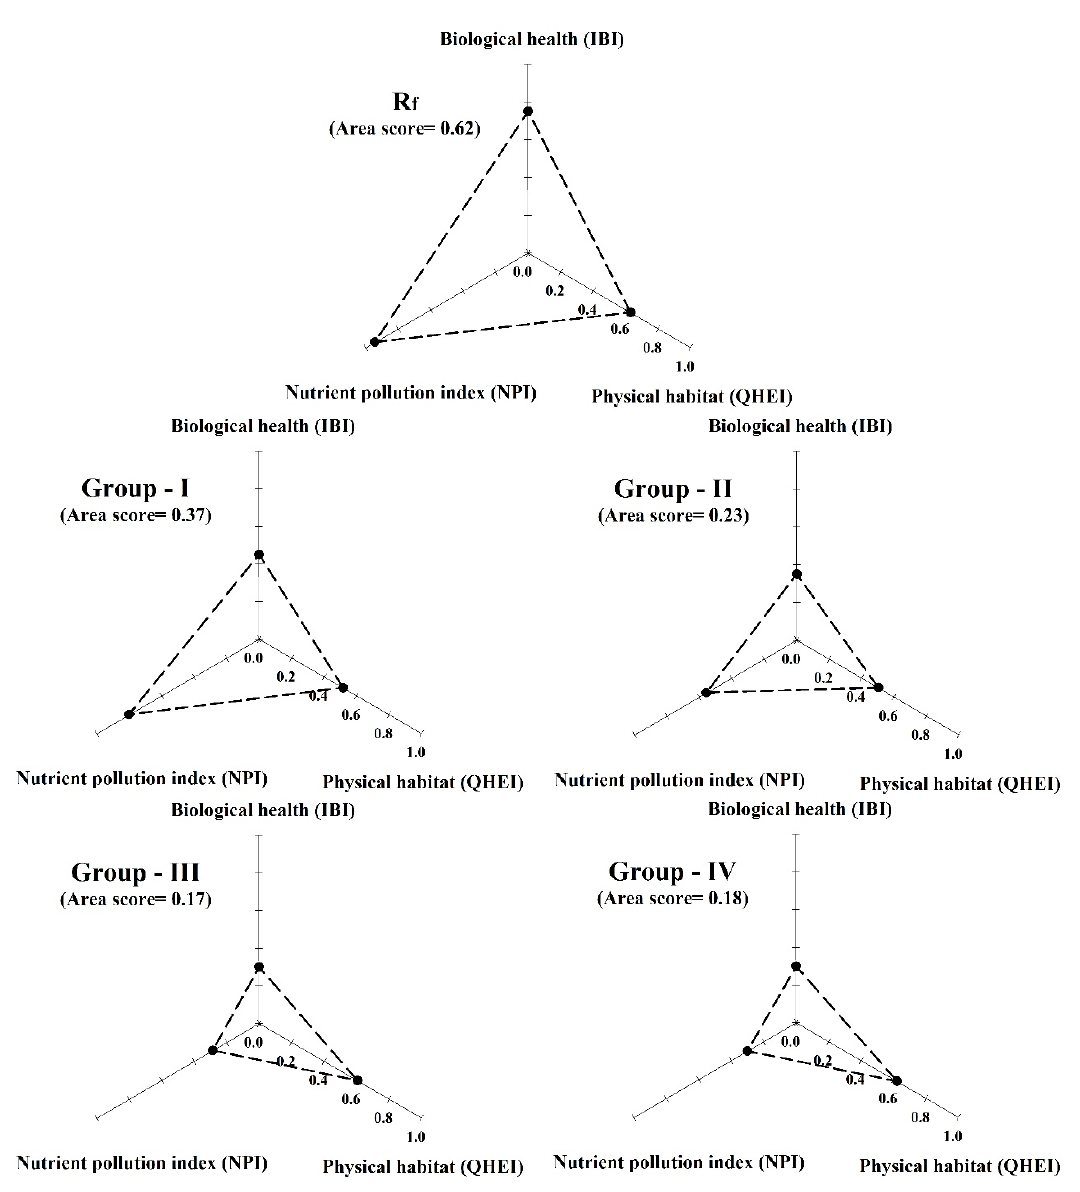
Figure 7. Integrated health responses (IHRs) using the star-plot area analysis in Nakdong